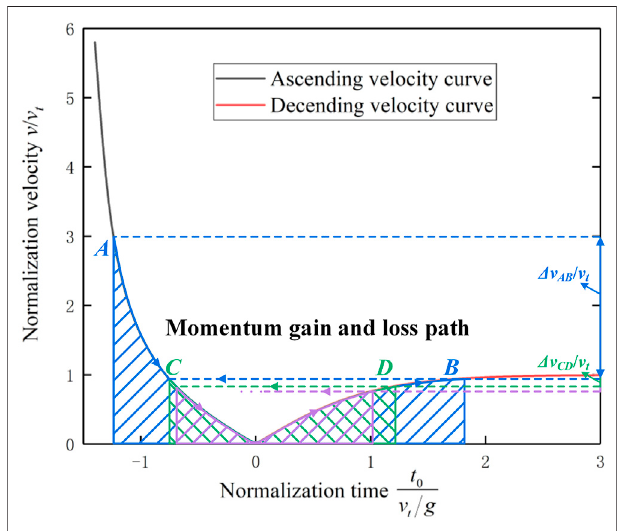
FIGURE5| Curve ofparabolic motionspeed withtime andtransferpath of particle momentum.